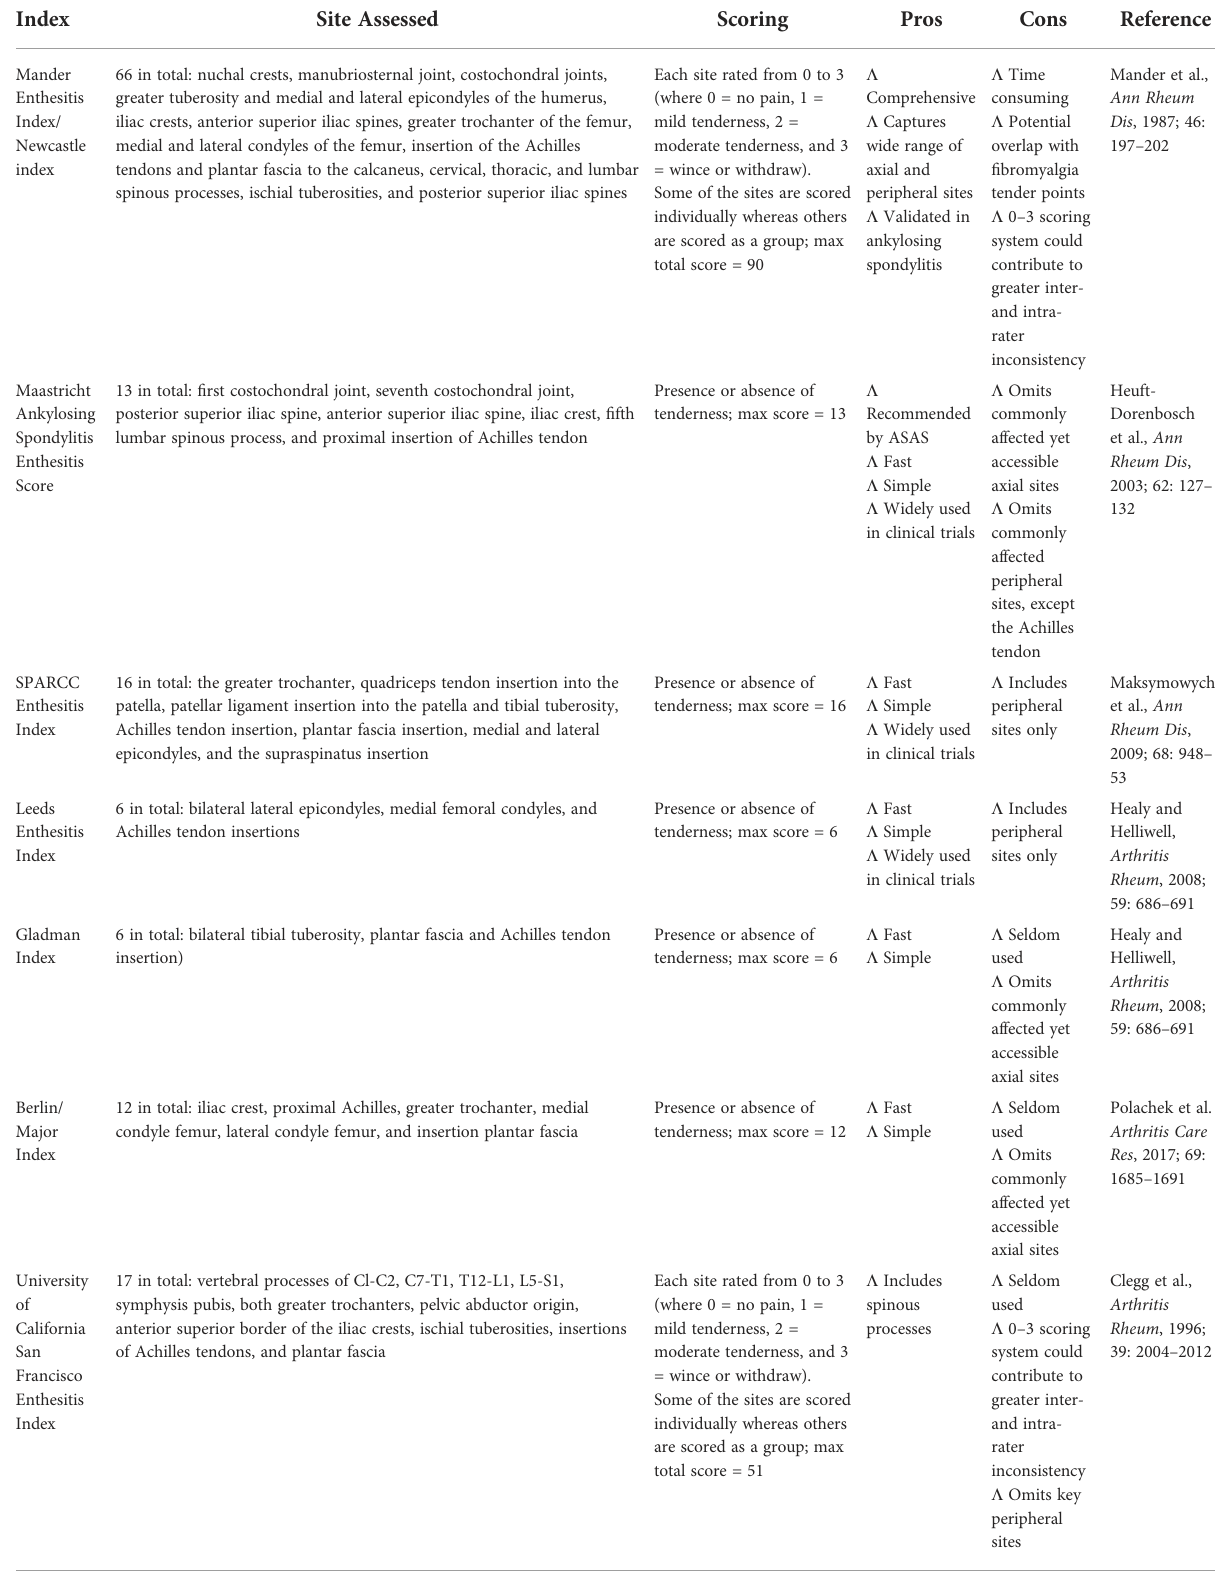
TABLE 2 Overview of physical examination systems used to assess enthesitis in patients with SpA (Ref. McGonagle et al., Semin Arthritis Rheum ., 2021 Jul 9; 51(6): 1147 – 1161). Index Site Assessed Scoring